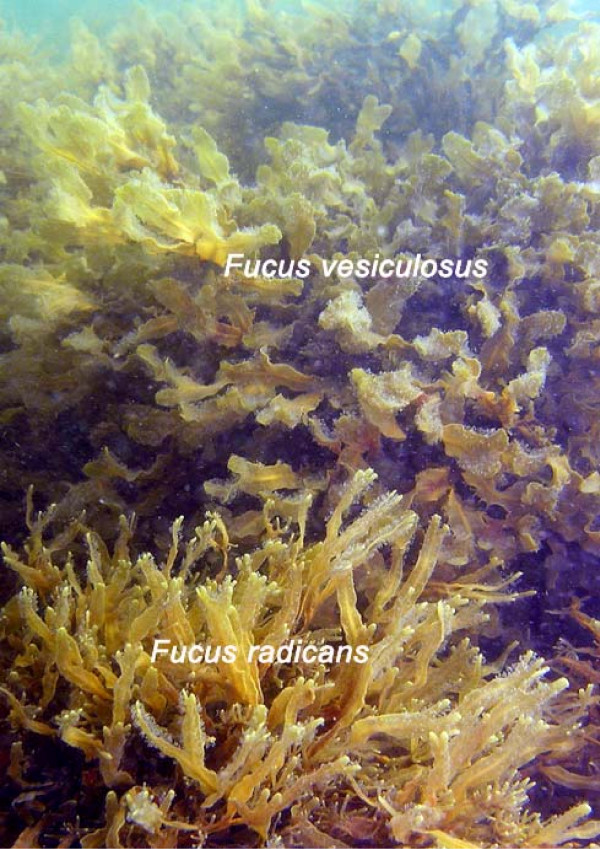
Fucus radicans and F. vesiculosus. Picture showing both Fucus species living in sympatry without any environmental discontinuity in the SW Gulf of Bothnia (northern Baltic Sea).